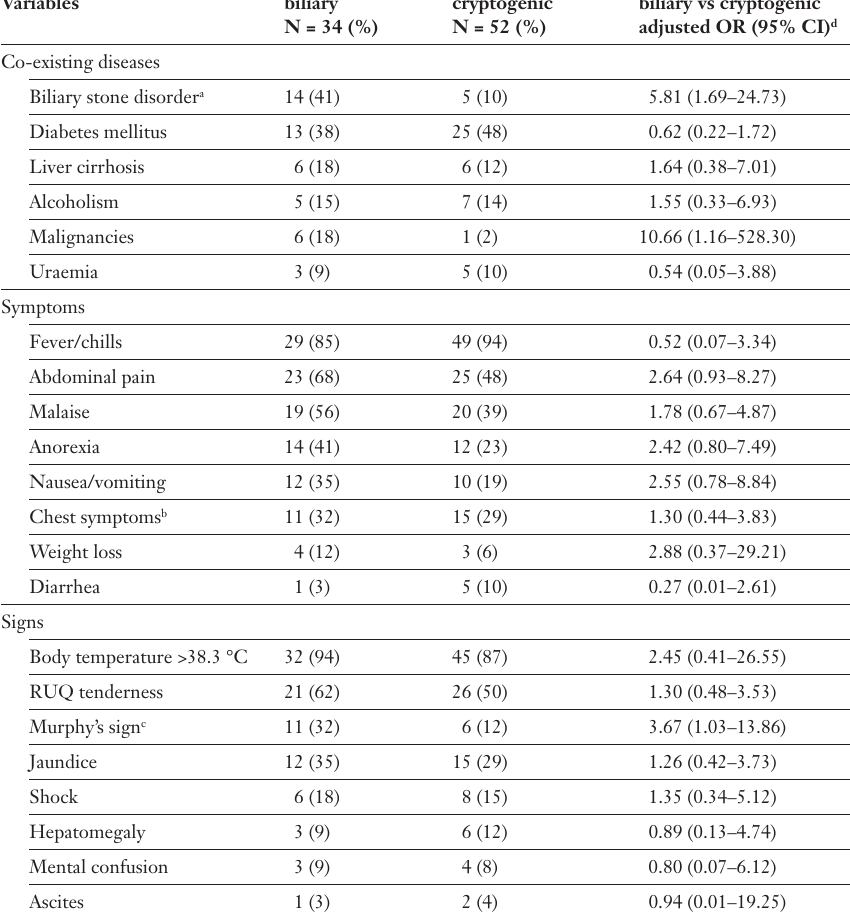
Underlying diseases, and clinic features in the biliary and cryptogenic